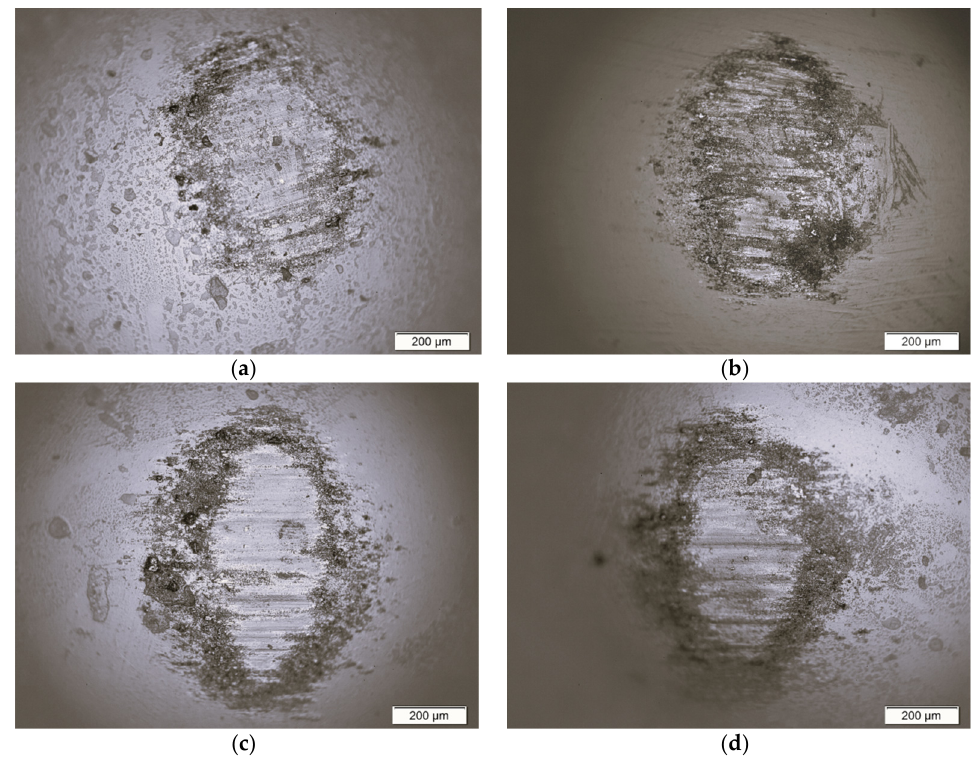
Figure 4. ZrO 2 ball wear scar after the ball-on-flat biotribological test against ( a ) Ti–13Zr–13Nb sub- strate; ( b ) 1G ONT layer; ( c ) 2G ONT layer; ( d ) 3G ONT layer. substrate; ( b ) 1G ONT layer; ( c ) 2G ONT layer; ( d ) 3G ONT